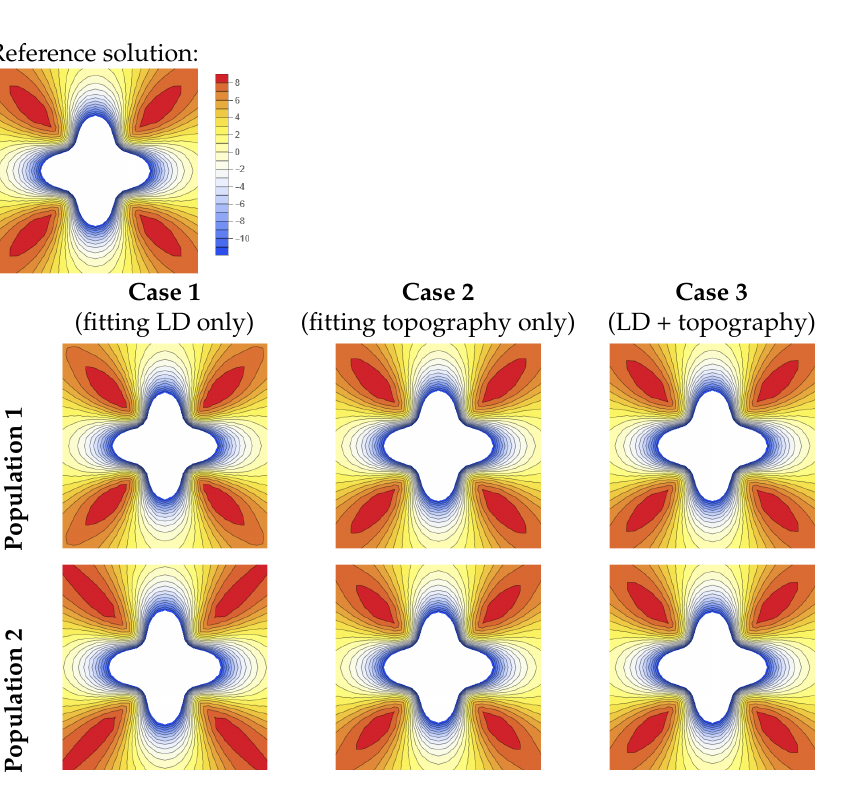
Figure 6. The surface topographies in the reference solution and each of the EA runs. Heights are given in µ m.